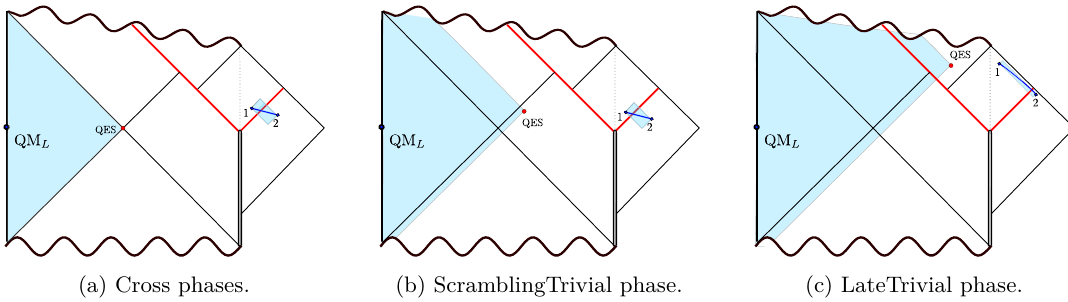
Figure 12. A sketch of the entanglement wedges for the different phases of the entanglement entropy for QM L +finite segment during intermediate